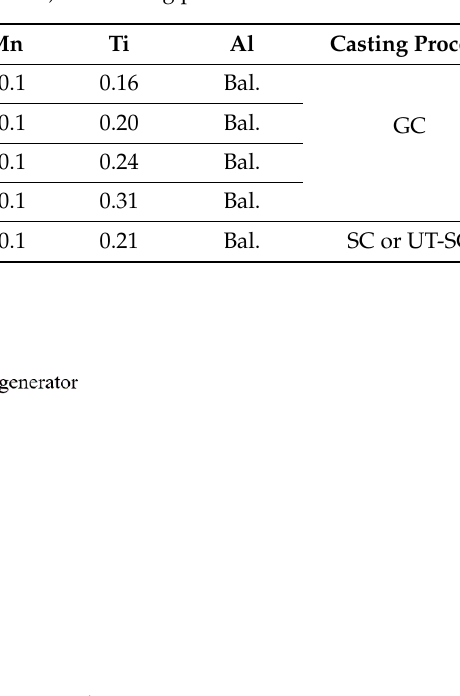
Figure 1. Diagram of ultrasonic vibration treatment equipment.